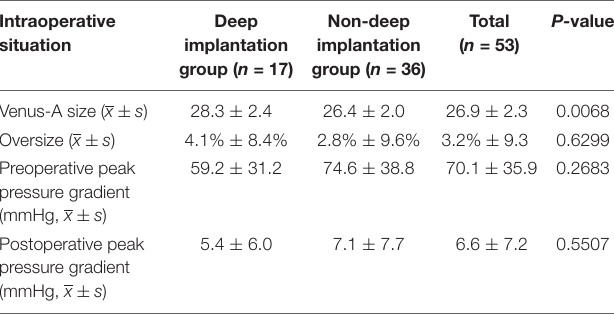
TABLE 1 | Comparison of intraoperative conditions between deep implantation group and non-deep implantation group of the Venus-A